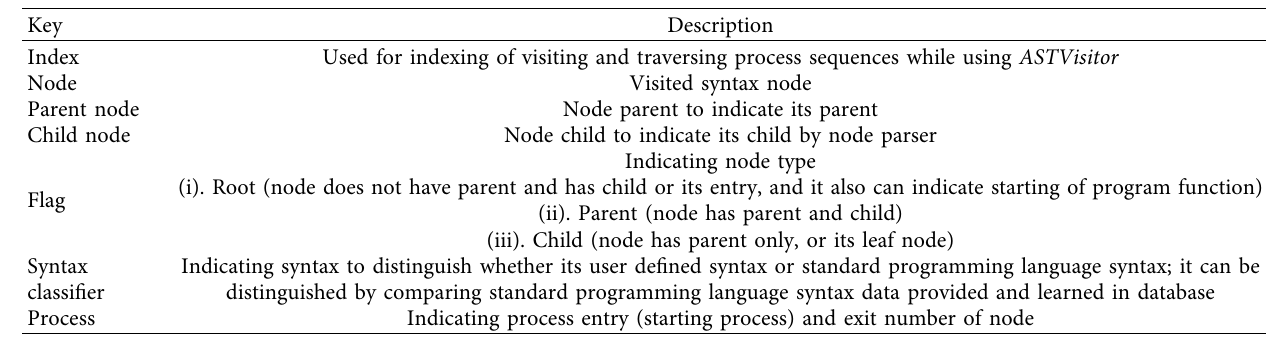
Table 3: AST data